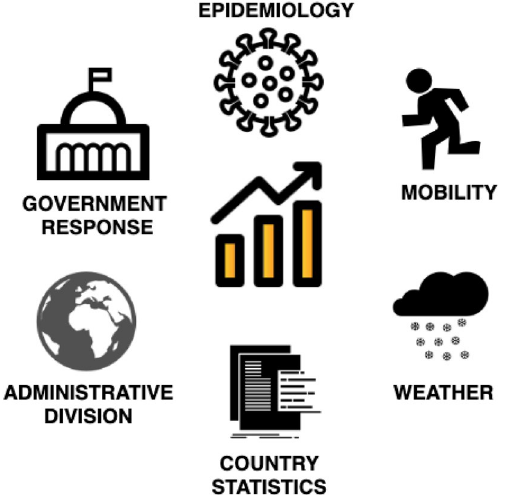
Figure 1. The main types of data categories included in the OxCOVID19